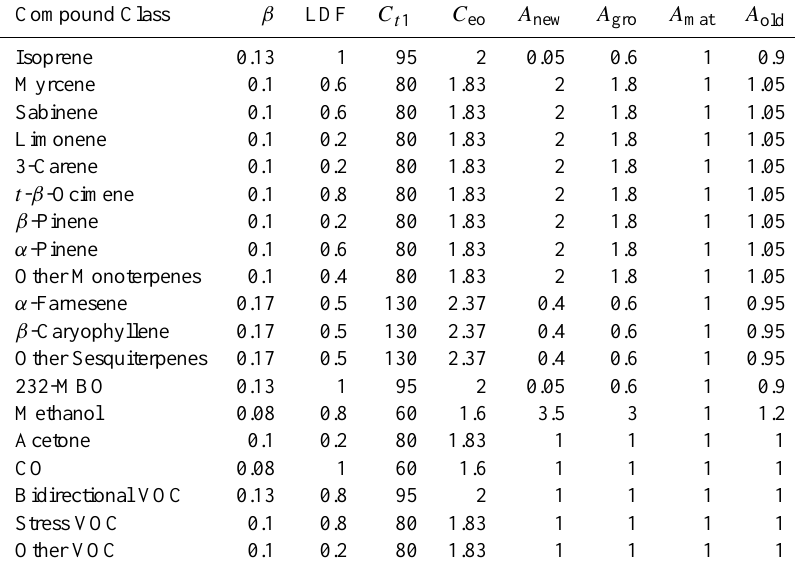
Table 4. MEGAN2.1 model